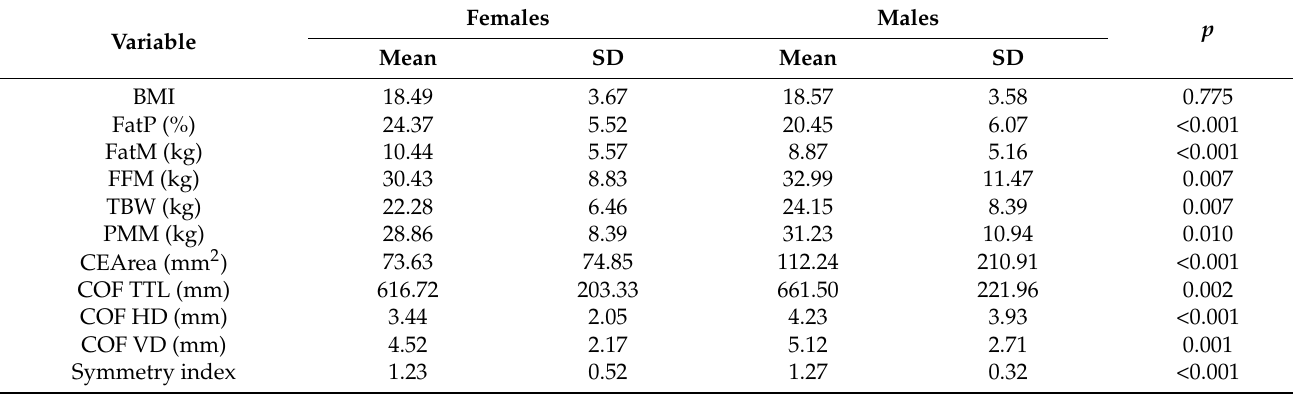
Table 2. Comparison of results of body weight composition, BMI and balance measurements by gender. Variable